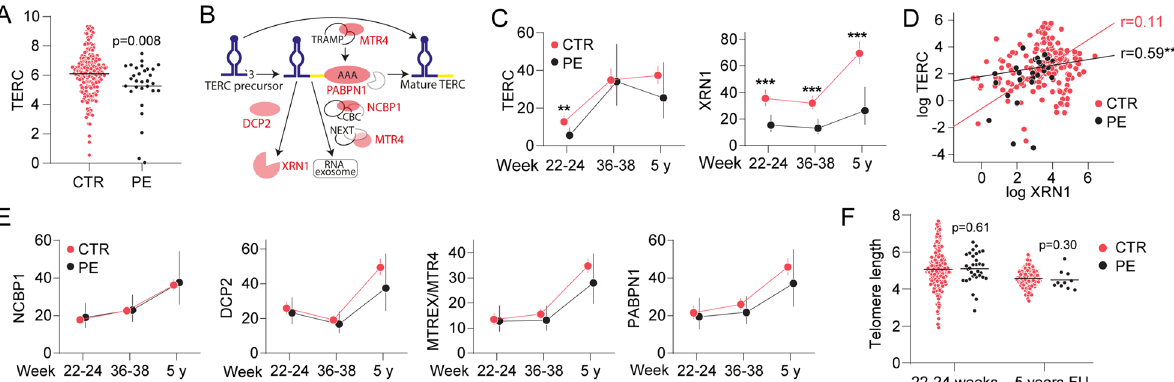
Figure 1. Expression levels of TERC and mRNAs of genes involved in the maturation of TERC and telomere length in PBMC ( A ) TERC expression from PBMC at 22–24 weeks in 182 controls and 38 PE ( B ) overview of the genes involved in the maturation of TERC , adapted from Roake et al. 4 (Adobe Inc. (2019). Adobe Illustrator. Retrieved from https:// adobe. com/ produ cts/ illus trator) ( C and E ) longitudinal expression of TERC during pregnancy and follow-up and some of the genes involved in the maturation of TERC ( D ) correlation (Pearson) between TERC and XRN1 within the control and PE group at 22–24 weeks gestation ( F ) telomere length in DNA from PBMC at 22–24 weeks and EDTA full blood at 5 years follow-up. ** p < 0.01, *** p <